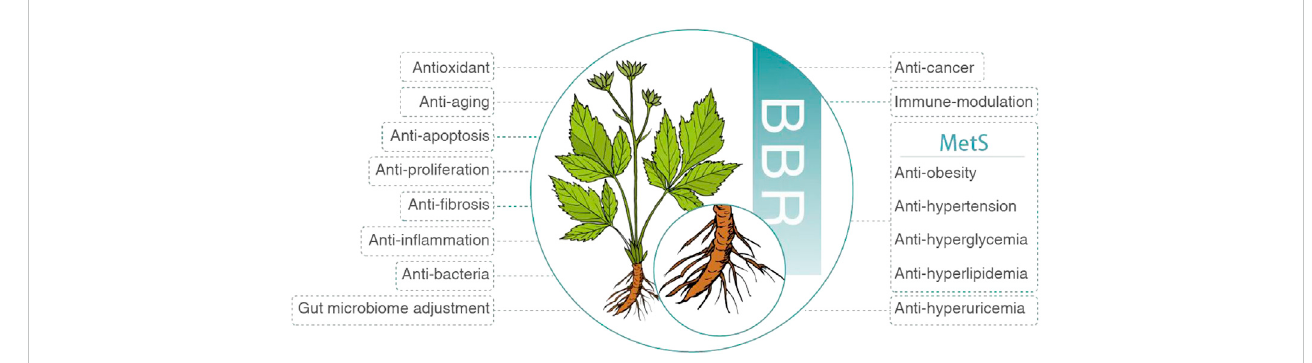
Pharmacological properties of BBR. BBR, berberine; MetS, metabolic syndrome.